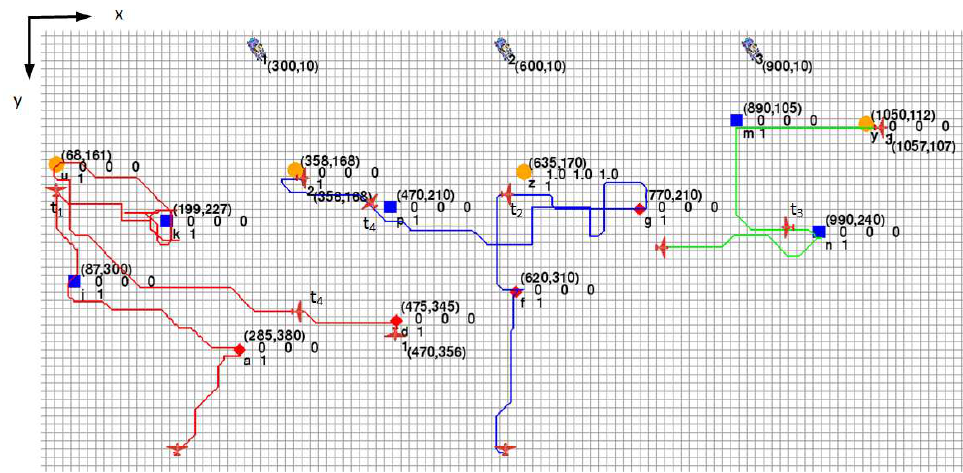
Figure 3. Simulation scene with the trajectories of planes represented by different colored